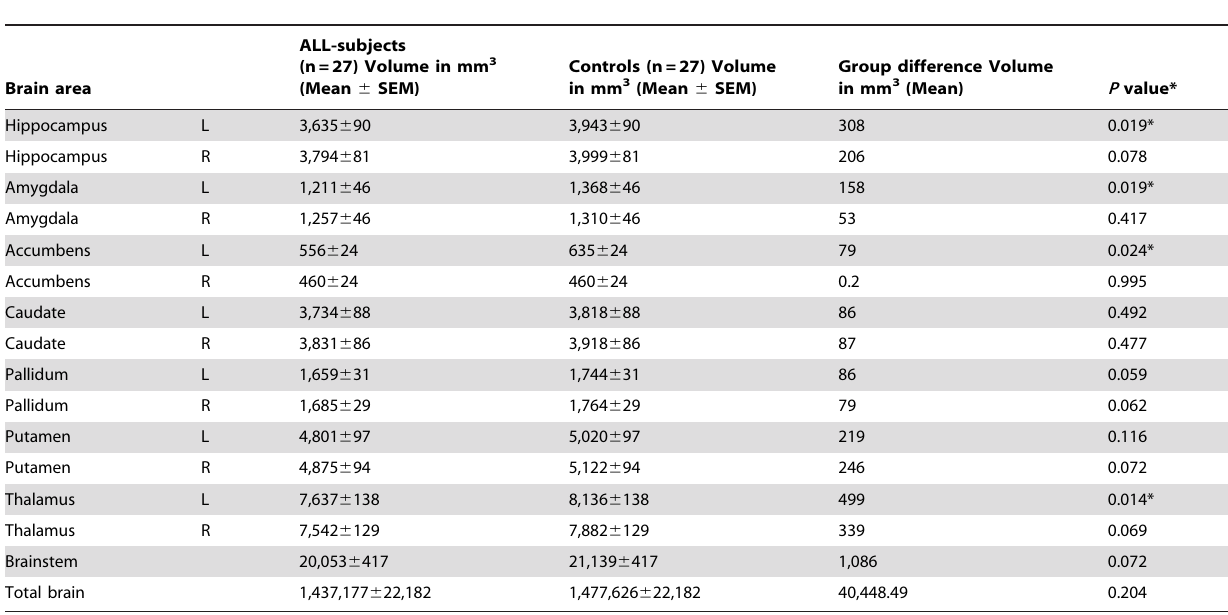
Table 2. Smaller volumes of subcortical structures in ALL-subjects compared to controls as revealed by FIRST analysis.